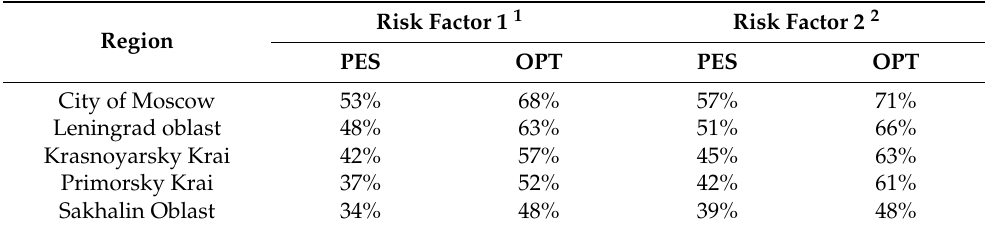
Table 2. Assessment of risk factors influence on achieving the goals for MSW sorting in selected regions of the Russian Federation (Part I).